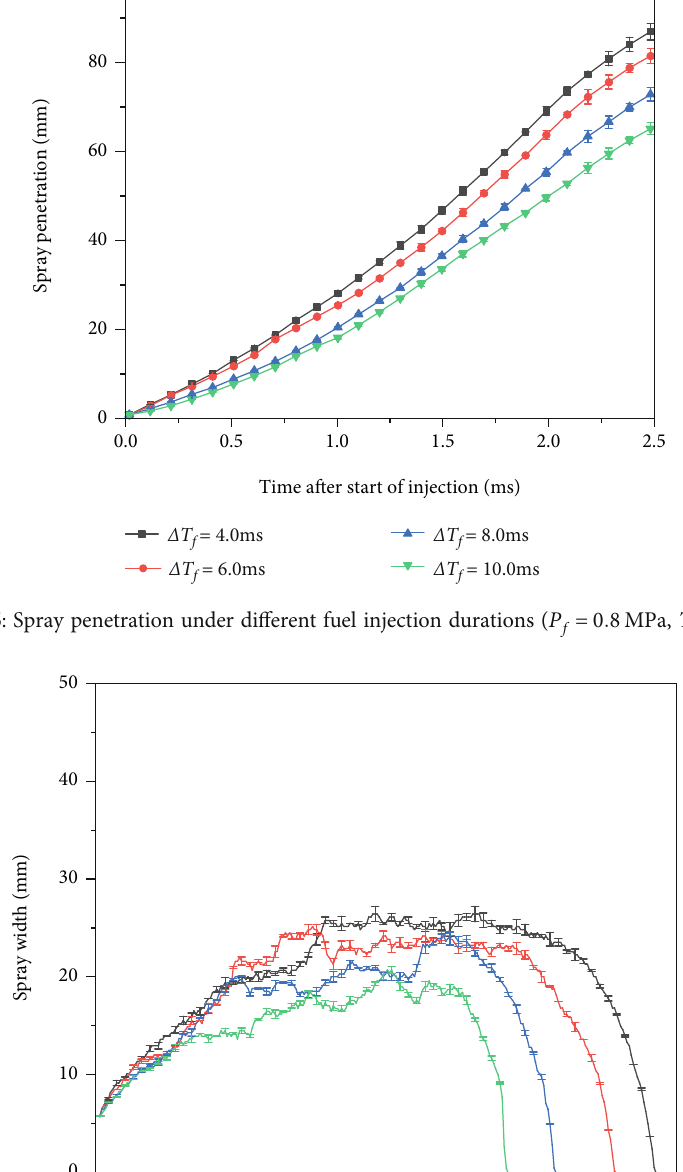
Figure 17: Spray width at di ff erent axial positions under di ff erent fuel injection durations ( t = 2 : 5 ms , P